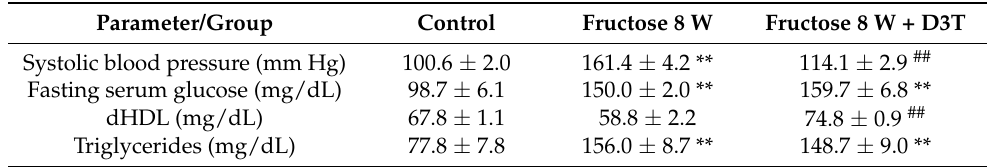
Table 2. General characteristics of the 3 groups of